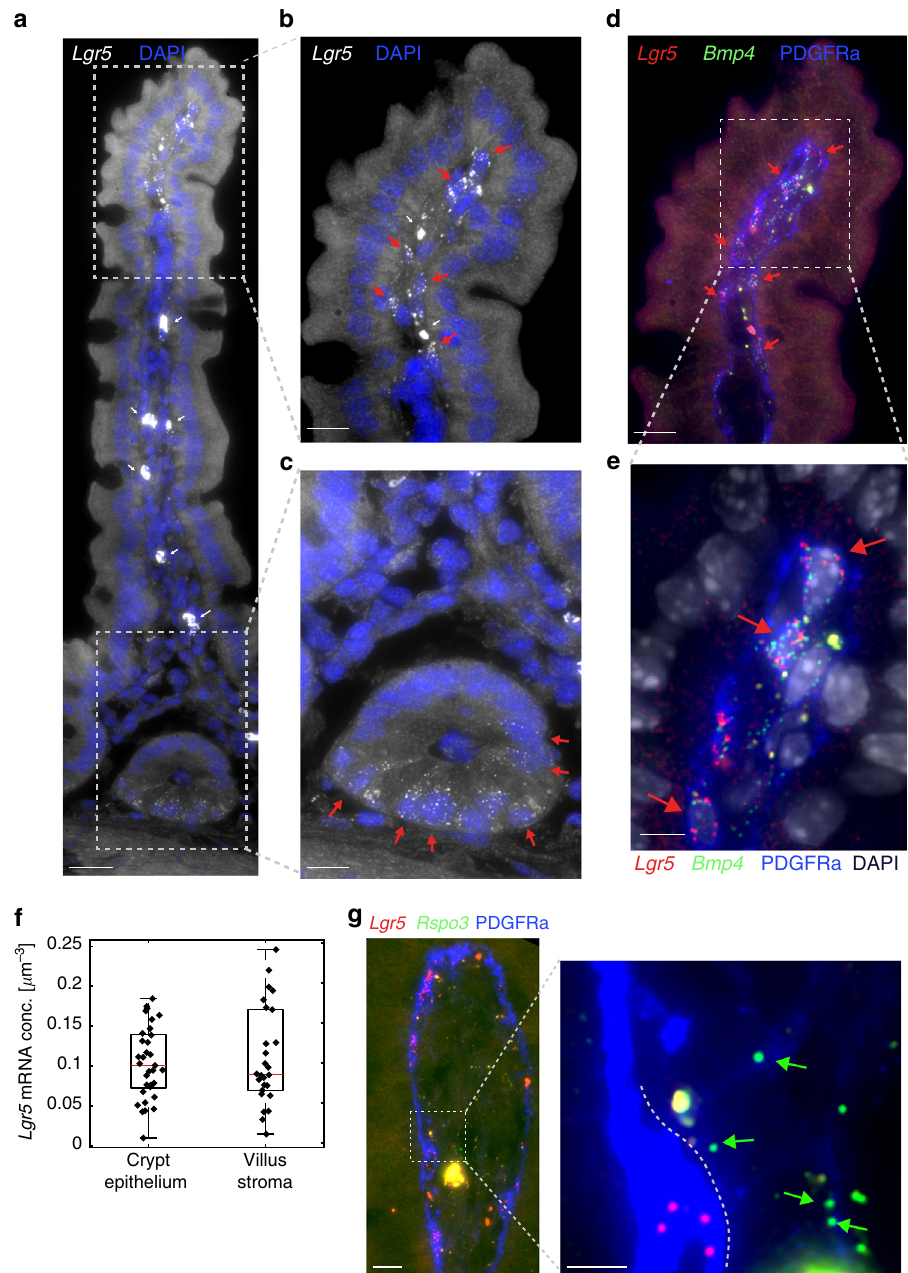
Fig. 2 Lgr5 is expressed abundantly in villus tip telocytes. a smFISH of Lgr5 , DAPI in blue, Scale bar – 20 µ m. b Blow up of villus tip, Scale bar – 10 µ m. In a, b thin white arrows point at auto fl uorescent blobs. c blow up of crypt, Scale bar – 10 µ m. Red arrows in b – c point to Lgr5 positive cells. d Lgr5 mRNA (red dots) expressed in PDGFRa + VTTs that co-express Bmp4 mRNA (green dots). Scale bar – 10 µ m. Red arrows point to Lgr5 and Bmp4 double positive cells. e Blow up of the region boxed in d . Scale bar – 5 µ m. f Lgr5 mRNA concentrations in VTTs are comparable to those in Lgr5 + crypt base columnar cells ( n = 25 cells examined over 2 mice for each region). Boxes show 25 – 75 percentiles of the smFISH expression, horizontal red lines are medians. Whiskers, extend to the most extreme data point within 1.5× the interquartile range (IQR) from the box; g ) Rspo3 mRNAs are localized on telopodes that extend away from the cell bodies of the VTTs. VTTs are marked by Lgr5 mRNA (red dots), Rspo3 mRNA (green dots) is localized away from the cell body, PDGFRa antibody mark VTTs cell bodies and telopodes. Scale bar – 10 µ m, in inset, green arrows point to Rspo3 mRNAs (green dots) localized on PDGFRa telopodes (blue). Telocyte cell body is marked by white dashed line. inset Scale bar – 5 µ